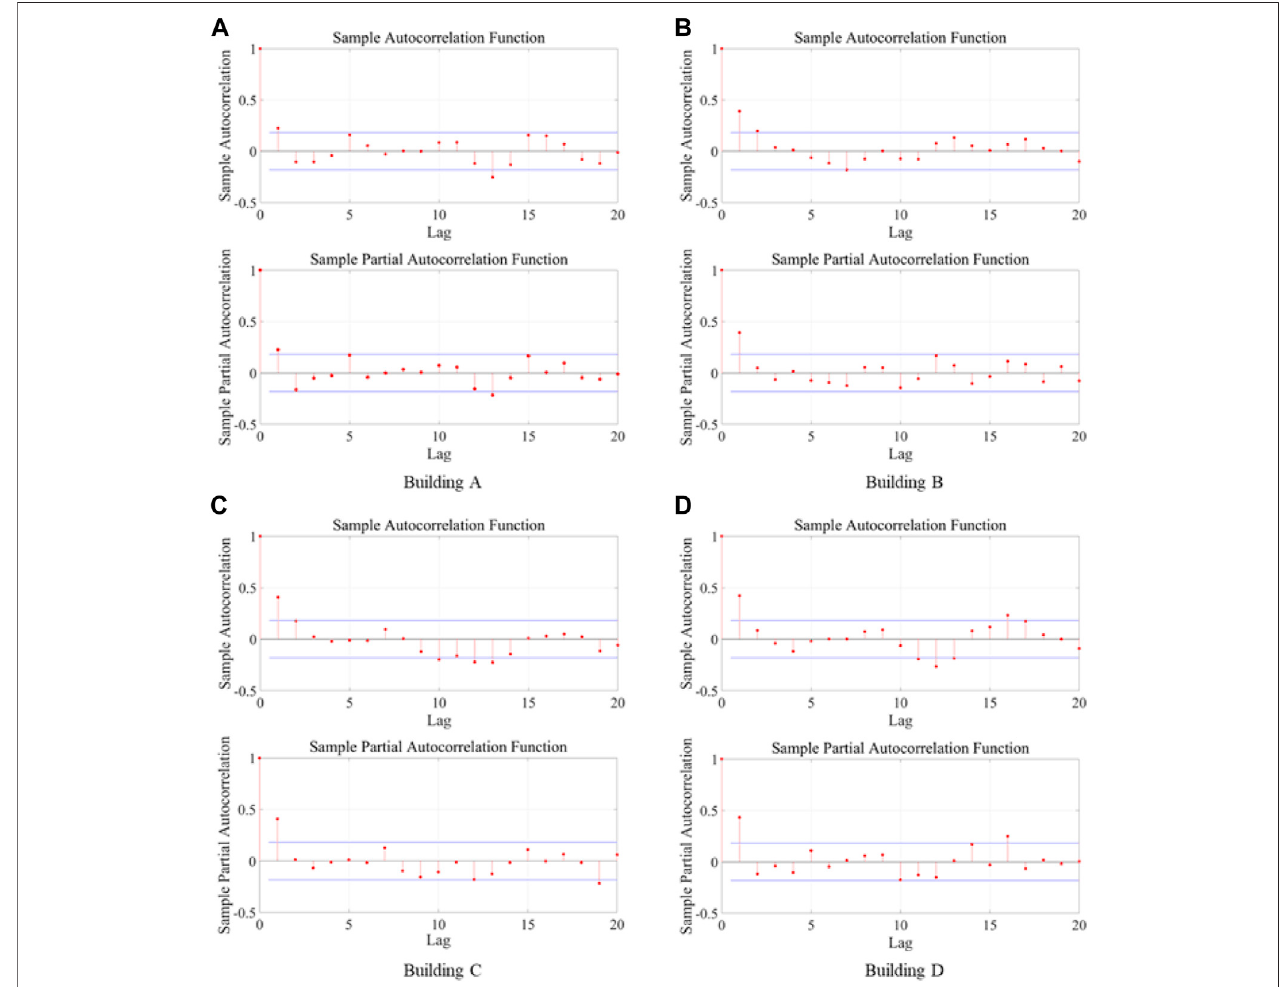
FIGURE 7 | Computed ACFs and PACFs for the four cases study time-series.